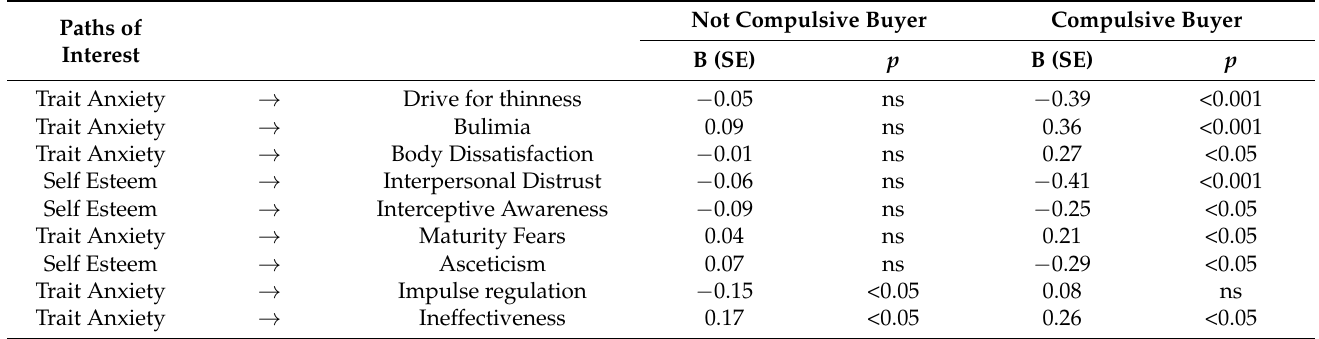
Table 4. Summary of path analysis between variables of our model among the compulsive/not- compulsive with equality constraints between the